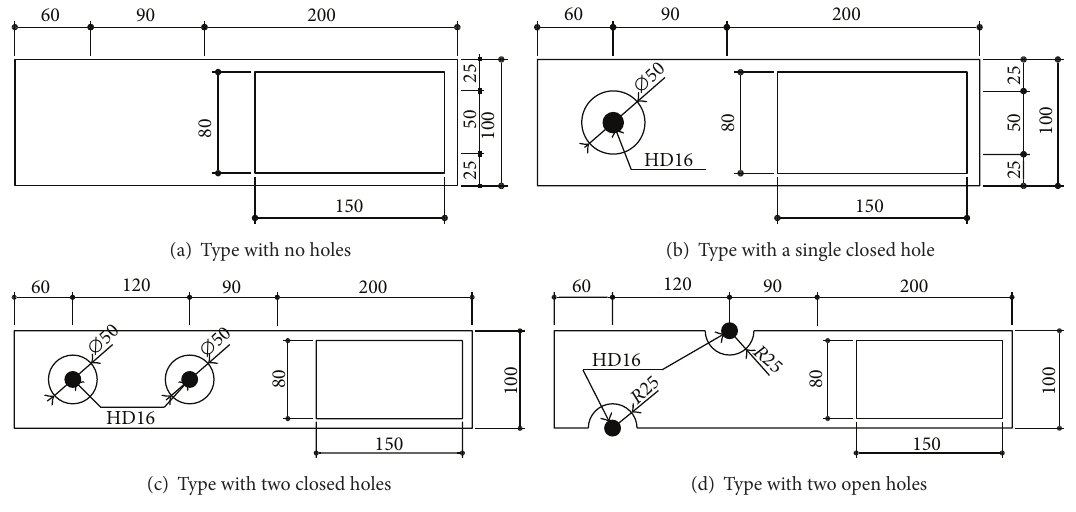
Figure 4: Types of perfobond shear connectors (unit: mm).